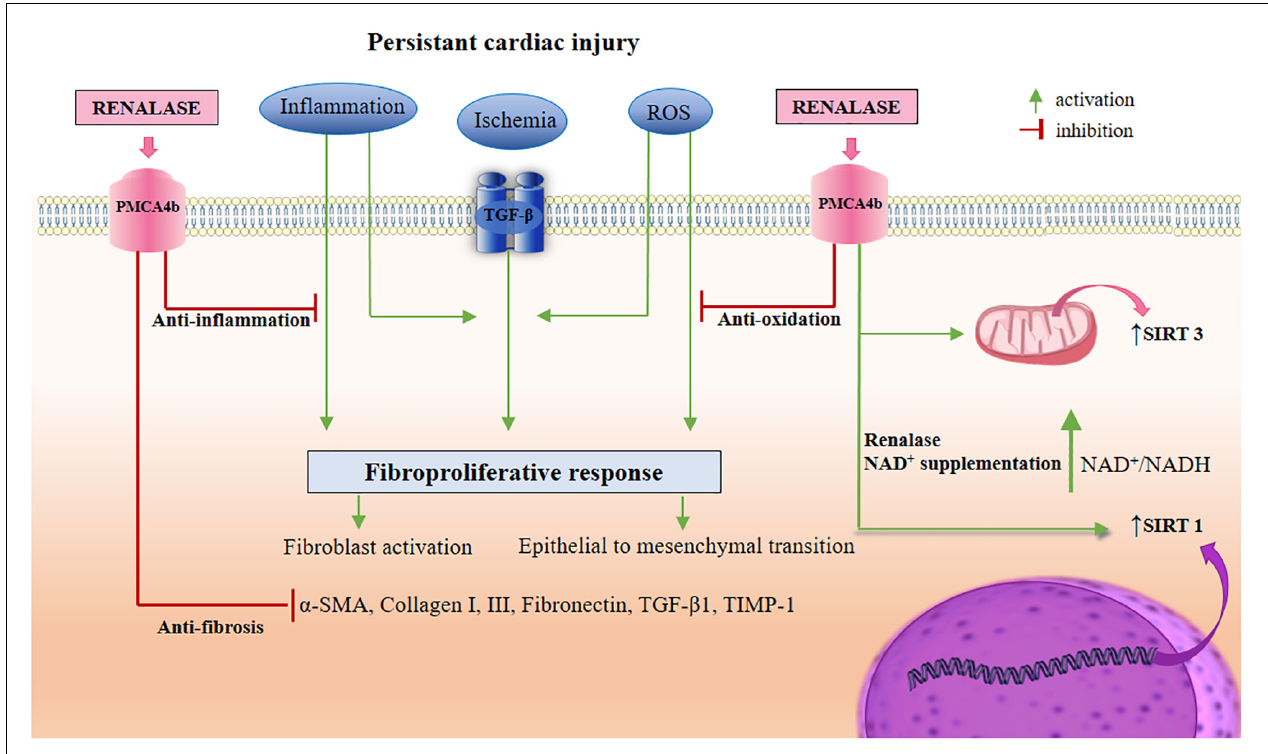
FIGURE 3 | A schematic view of renalase-targeted pathways in the TGF- β -induced cardiac fibrosis. As depicted in the Figures 1 , 2 , renalase likely regulates the actions of signaling branches in non-canonical pathways (ERK 1/2, JNK, p38, and PI3K/Akt), and several cellular effectors, in order to establish a state of anti-necrosis, anti-apoptosis, anti-inflammation, anti-oxidation, suppression of EMT, and anti-fibrosis. Simultaneously, renalase promotes the activation of SIRT1 via NAD + supplementation, which therefore presumably provides an indirect role in SIRT1 cardio-protection. These actions include: the reduction of ROS production, inflammation, cardiomyocytes apoptosis, and cardiac fibroblasts transdifferentiation, as well as increased autophagy, and fatty acid oxidation, thus inducing mitochondrial biogenesis. In addition, renalase, with NAD + supplementation, promotes SIRT3 activity, thus potentially upgrading SIRT3 cardio-protective properties, including: the alleviation of cardiomyocytes apoptosis, hypertrophy, and fibrosis, suppression of ROS production, and inflammation, extinguishing MAPK/ERK 1/2, and PI3K/Akt signaling, and EMT, which thereby increases autophagy for inflammasome suppression, and promoting mitochondrial energy production. TGF- β , transforming growth factor- β ; PMCA4b, plasma membrane calcium-ATPase 4b; ERK 1/2, extracellular regulated protein kinases 1/2; JNK, c-Jun N-terminal kinases; PI3K/Akt, phosphatidylinositol 3-kinase/protein kinase B; EMT, epithelial to mesenchymal transition; SIRT, sirtuin; NAD, nicotinamide adenine dinucleotide;